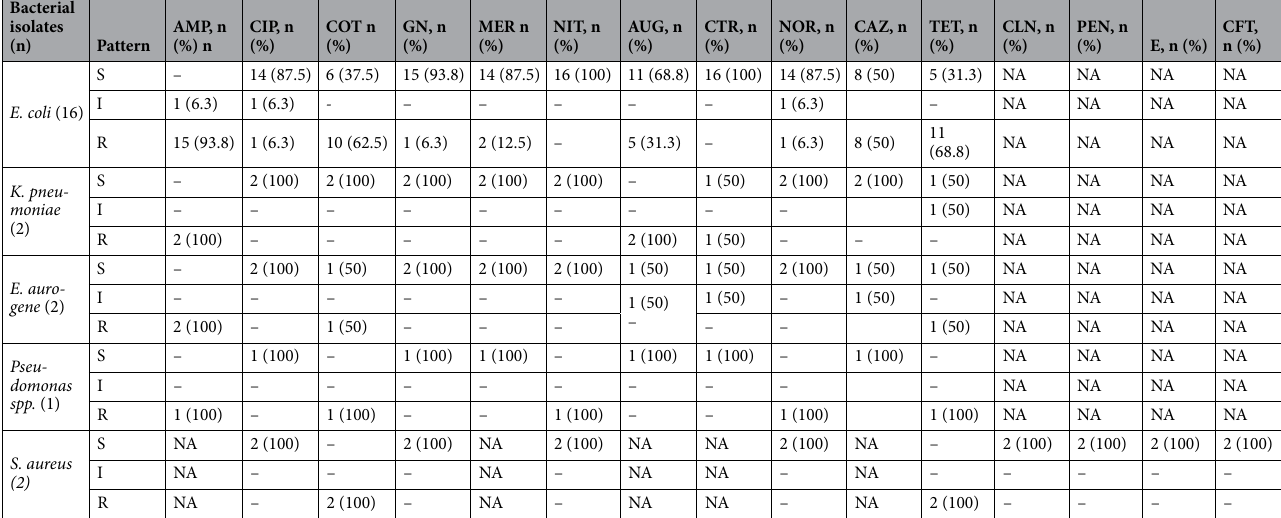
Table 4. Antimicrobial susceptibility pattern of Gram-negative and Gram positive bacteria isolated from urine culture of people living with HIV attending Hawassa University Comprehensive Specialized Hospital ART